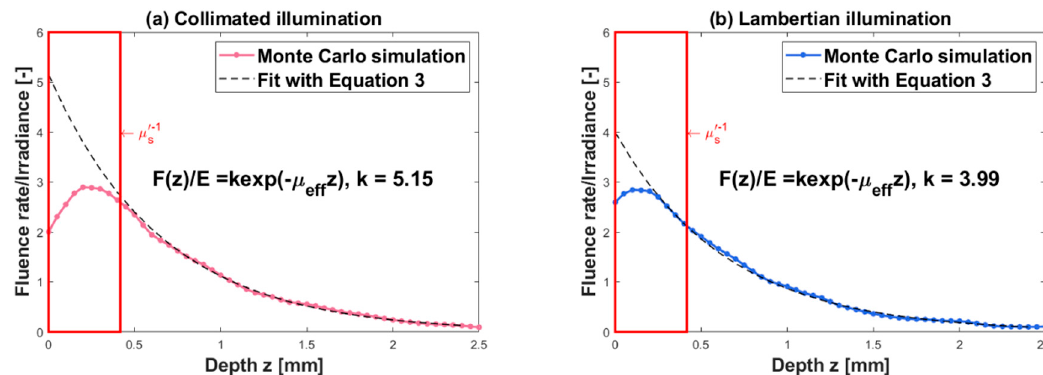
Figure 4. ( a ) Monte-Carlo simulation of the evolution of the normalized fluence with depth in a semi-infinite tissue presenting the optical properties reported by Roggan [44] at 630 nm for the aorta ( µ a = 0.29 mm − 1 ; µ s ’ = 2.40 mm − 1 ; µ e ff = 1.53 mm − 1 ). The air–tissue interface is illuminated at 90 degrees with a broad and collimated light beam. The dashed line corresponds to a fit of the simulation with Equation (3). ( b ) Same condition, excepting that the illumination of the air–tissue interface is Lambertian.